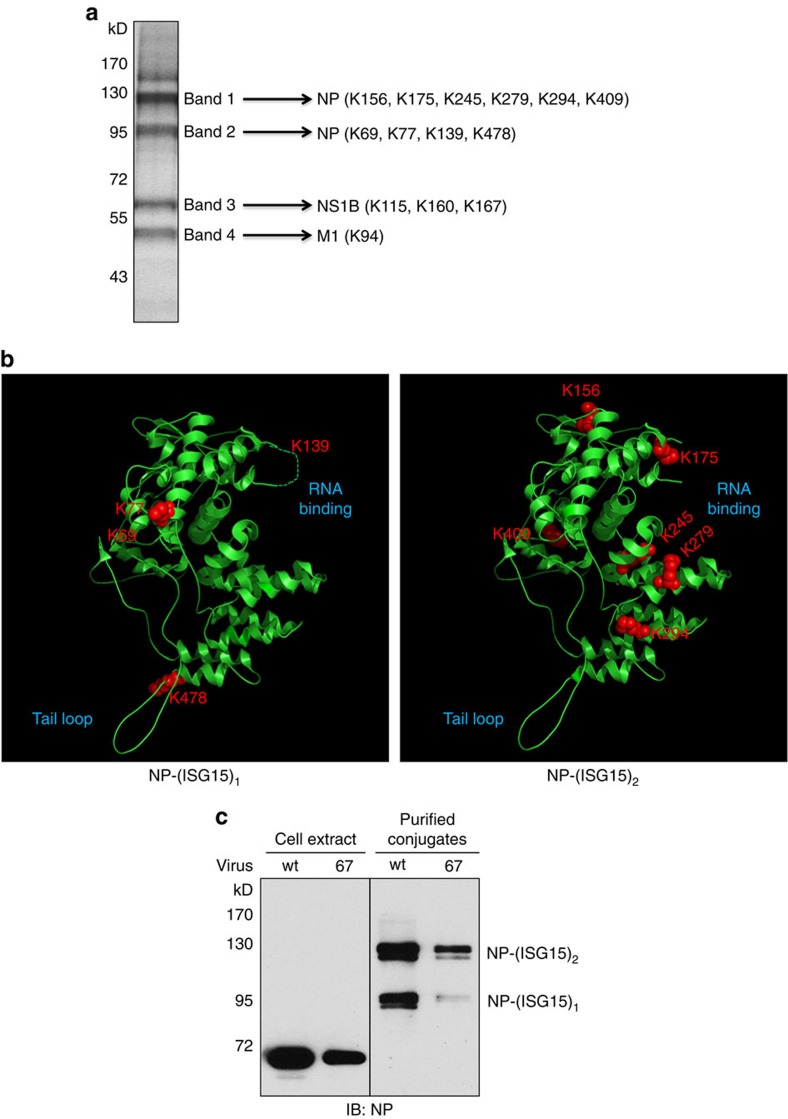
The major target of ISGylation in influenza B virus-infected cells is NP.(a) Colloidal blue-stained gel of ISG15 conjugates purified by double-affinity selection from S-3F-ISG15GG A549 cells which were pretreated with IFN-β and then infected with wt virus for 24 h. The four bands that were analysed by mass spectrometry and the ISG15 conjugation sites that were identified in these four bands are shown. See also Supplementary Table 1. (b) Location of the ISG15-modified lysines (Ks) mapped onto the structure of influenza B virus NP (PDB accession code 3TJ0). (c) S-3F-ISG15GG A549 cells were pretreated with IFN-β and then infected with 10 p.f.u. per cell of wt or 67 mutant virus for 24 h. Cell extracts and ISG15 conjugates purified from these extracts by double-affinity selection were analysed by immunoblots probed with NP Ab.